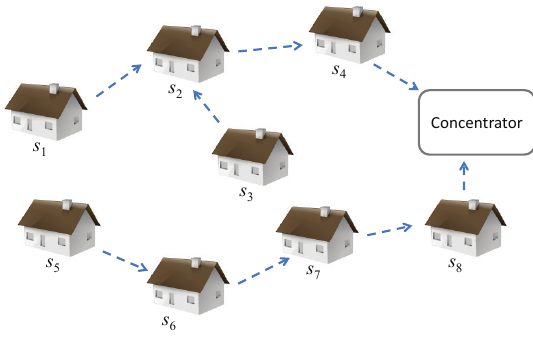
Figure 2. Data aggregation